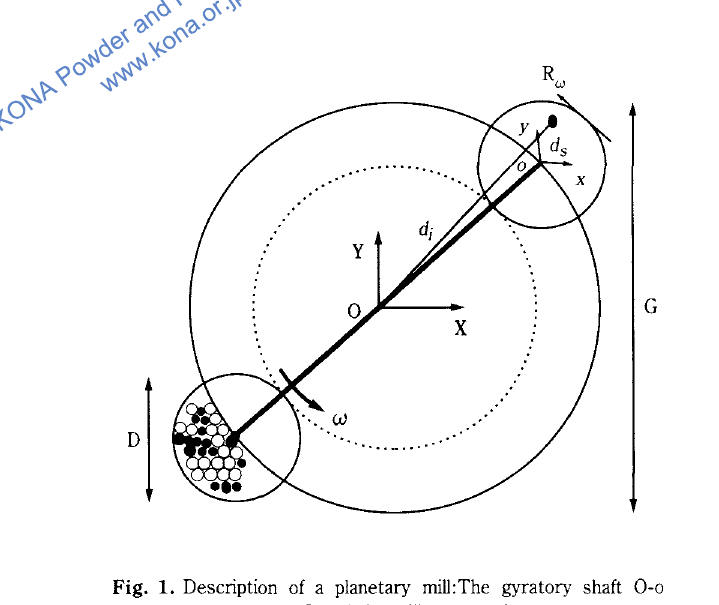
Fig. 1. Description of a planetary mill:The gyratory shaft 0-o rotates about 0 and the mill rotates about